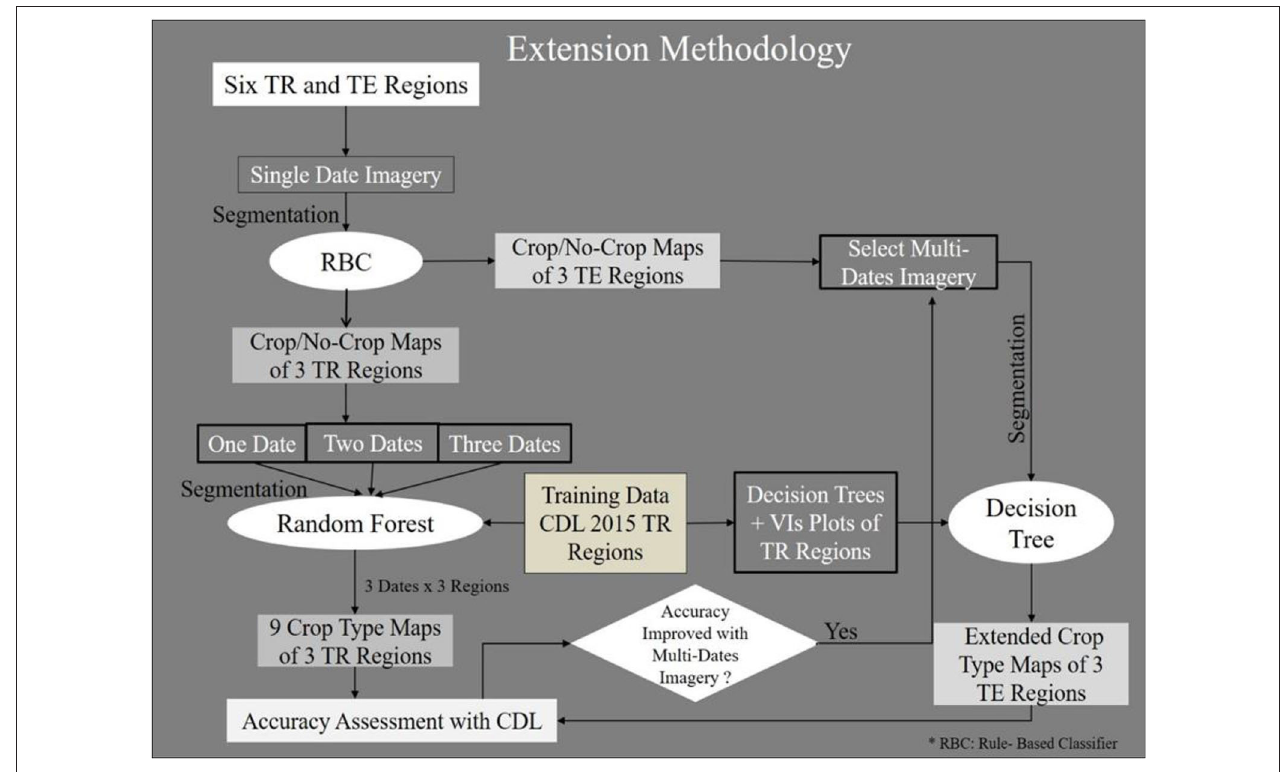
FIGURE 3 | The overall methodology flow chart showing the extension of the limited crop type reference data for the six